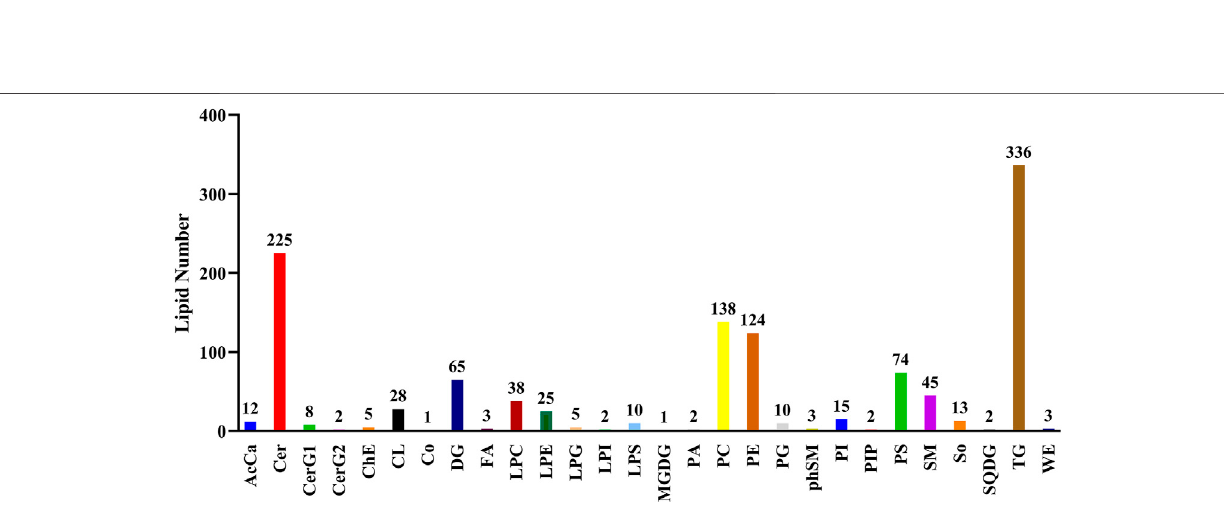
Frontiers in Pharmacology |